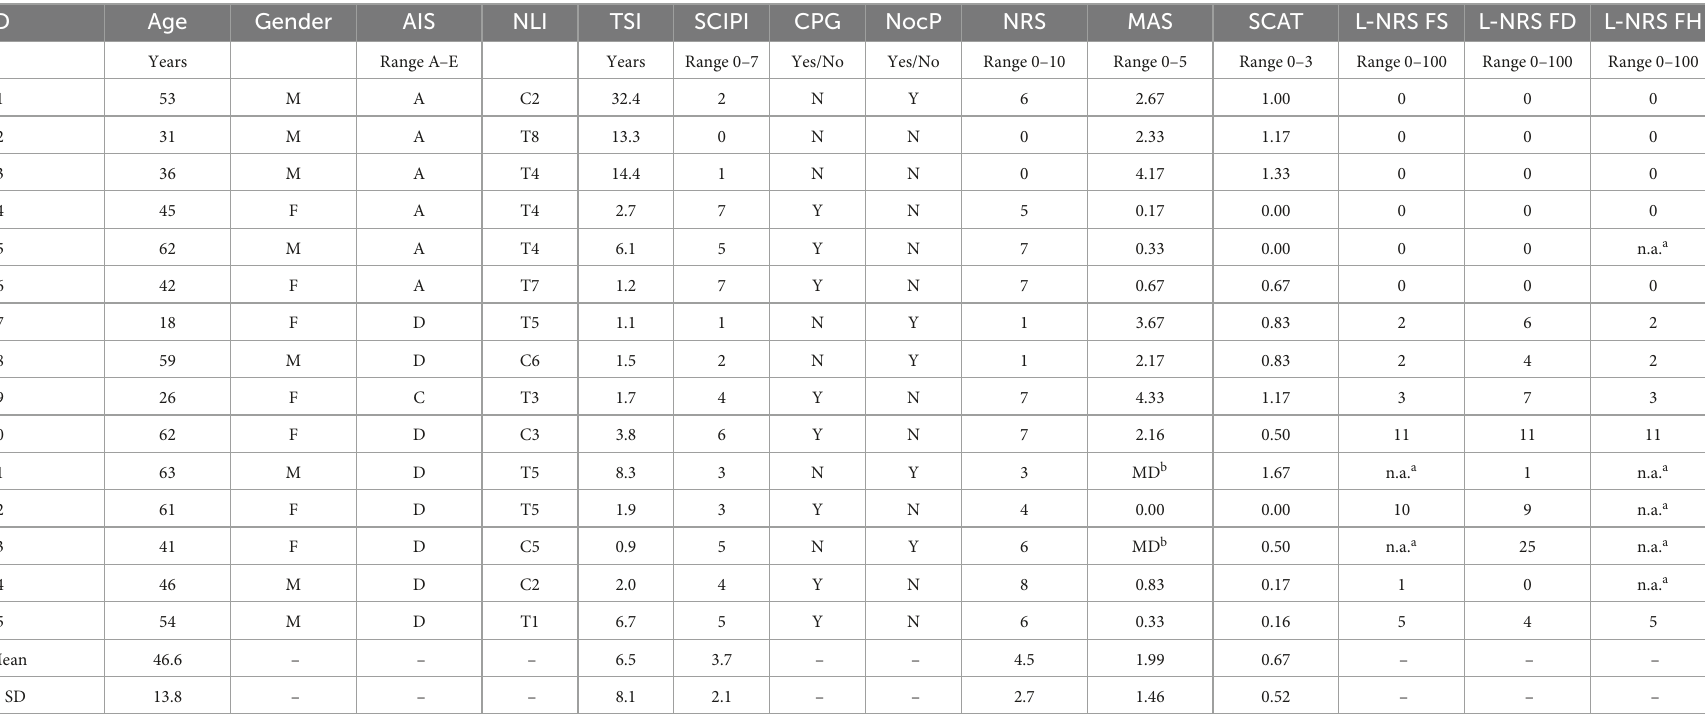
TABLE 1 Demographics and basic clinical characteristics of participants with spinal cord